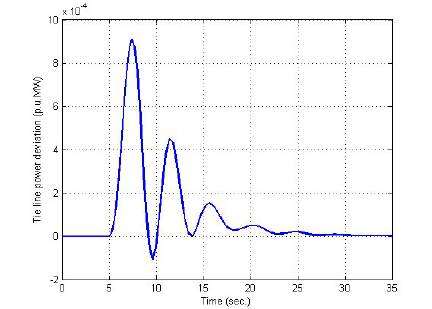
Fig. 4: Tie-line power deviation (Case 1)